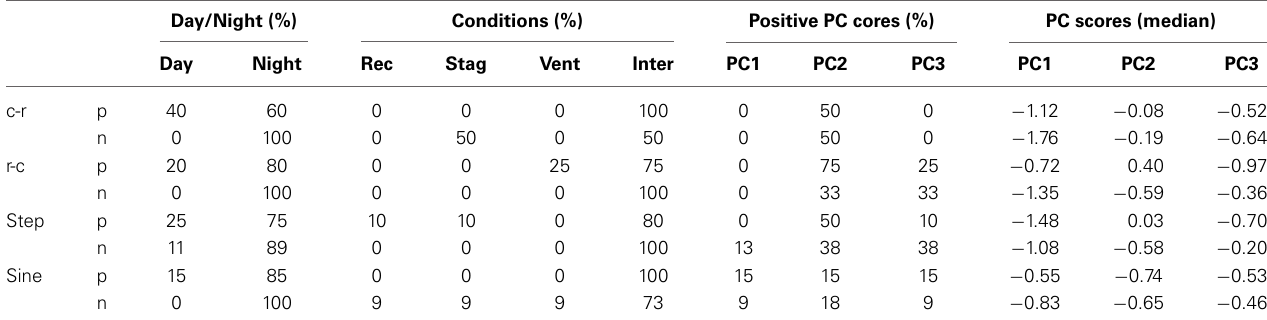
Table 3 | Statistics of the identified wind speed shapes according to the day period, status of the flow field and the dominant surface